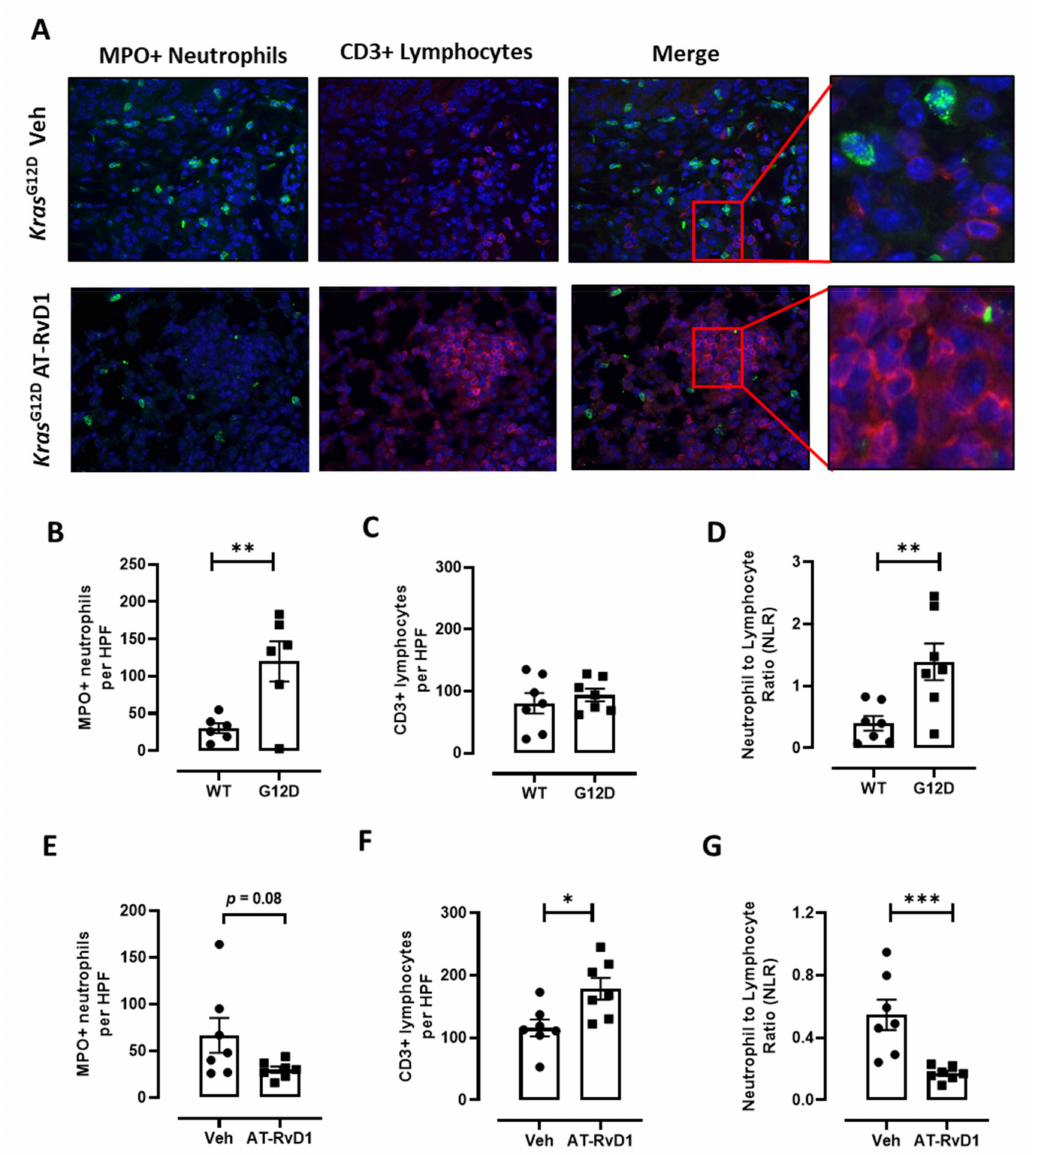
Figure 5. AT-RvD1 reduces the neutrophil to lymphocyte ratio. ( A ) Representative immunofluorescent images of MPO- positive neutrophils, CD3-positive lymphocytes and merged images (right panels) from Kras G12D mice that were intranasally treated with AT-RvD1 (400 ng, 2 × weekly) or vehicle over a 6-week period following Ad-Cre inhalation (original mag- nification × 200). ( B ) Quantification of MPO-positive and ( C ) CD3-positive cells per high powered field in lungs of the indicated genotype. ( D ) The neutrophil to lymphocyte (NLR) was determined for the same group of mice (NLR). n = 7 per group, ** p < 0.001, * p < 0.05 unpaired t test. Quantification of ( E ) MPO-positive and ( F ) CD3-positive cells HPF in lungs of Kras G12D mice treated with AT-RVD1 or vehicle. ( G ) The neutrophil to lymphocyte ratio (NLR). n = 7 per group, *** p < 0.0005, * p < 0.05 unpaired t